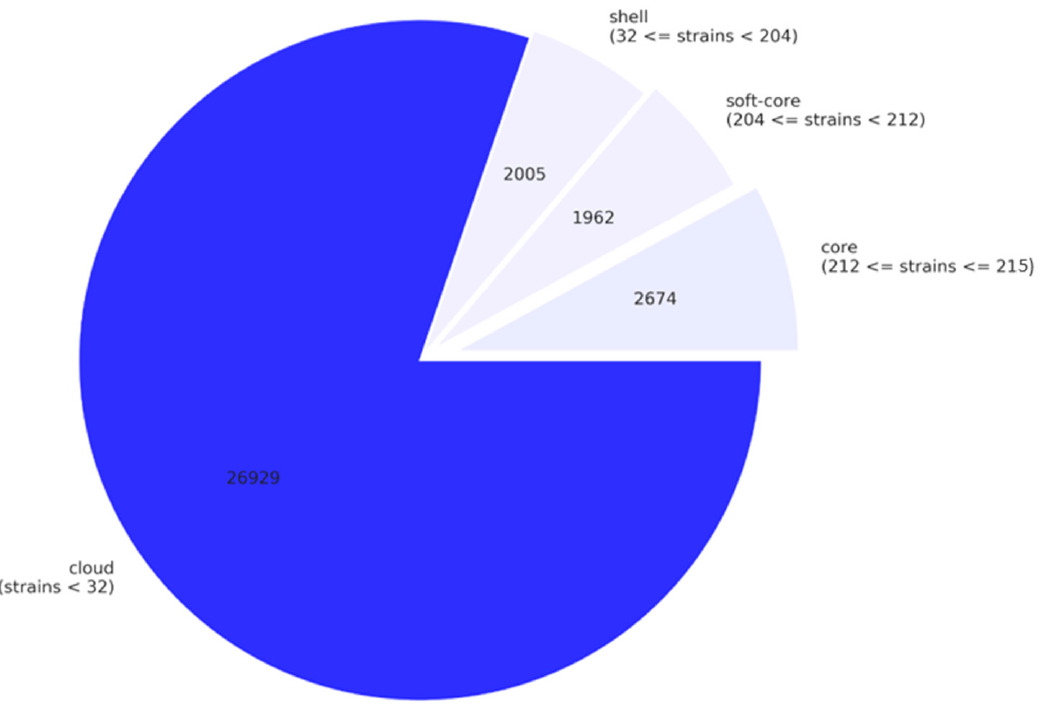
Figure 3. Pie chart of the breakdown of genes and the number of P. aeruginosa genomes in which they are present. Core genes are present in 99% or more of the genomes, soft core genes in 95% or more of the genomes and less than 99%, shell genes in between 15% and 95% and cloud genes in less than 15% of the genomes. This figure was created using the contributed Python script roary_plots.py in https://github.com/sanger-pathogens/Roary/blob/master/contrib/roary_plots/roary_plots.py. The total number of genes in the 136 crpP -harboring ICEs is 1193. We found 26 core genes (2.2% of all genes). The soft core content (genes present in 95% or more of the ICEs and less than 99%) includes 11 genes, 129 shell genes (between 15 and 95%) and 1027 cloud genes (less than 15%). We identified 451 unique genes among the crpP -harboring ICEs. Phylogenetic analysis of the crpP -harboring ICEs core alignment reveals that these ICEs are very diverse and the core genes only share 28.0% nucleotide identity (Figure